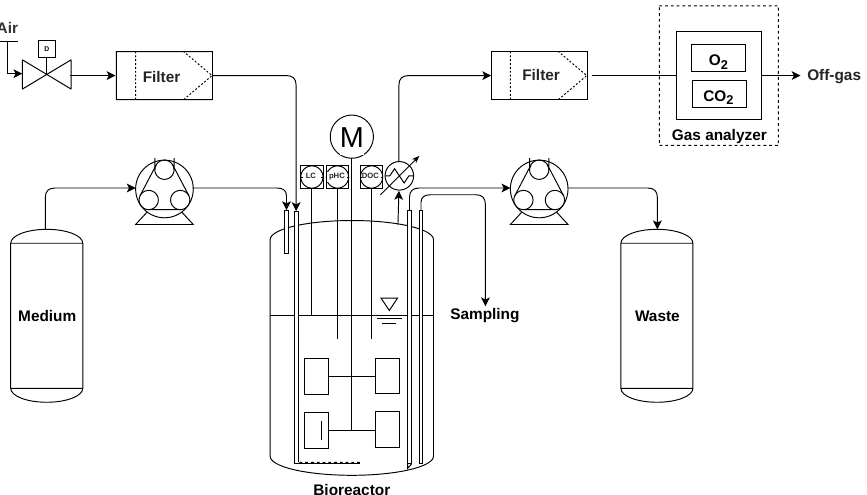
Figure 1. A simplified scheme of the experimental setup with one bioreactor is shown. Experiments were performed in four parallelized stirred-tank bioreactors. Sterile, pressured air was sparged at the bottom of the bioreactor and, upon exit, condensed at the bioreactor gas outlet by a reflux condenser, subsequently sterile-filtered, and passed through the off-gas analyzer. The RB medium was provisioned in 5 L flasks, which were exchanged with fresh medium every eighth batch. Removed biosuspension was pumped into a 50 L shared waste container. The bioreactor was filled and emptied by peristaltic pumps. A rising pipe with a beveled needle point style end (bevel angle of 90 ◦ ) was constructed to empty the bioreactor adequately. In-line probes for medium exchange-control, pH-control, and DO-control were inserted through the bioreactor head. Two Rushton turbines (Rushton-Type stirrer, Eppendorf, Hamburg, Germany) were placed on the stirrer axis starting 5 mm above the end of the axis, with a vertical distance of 25 mm between the turbine